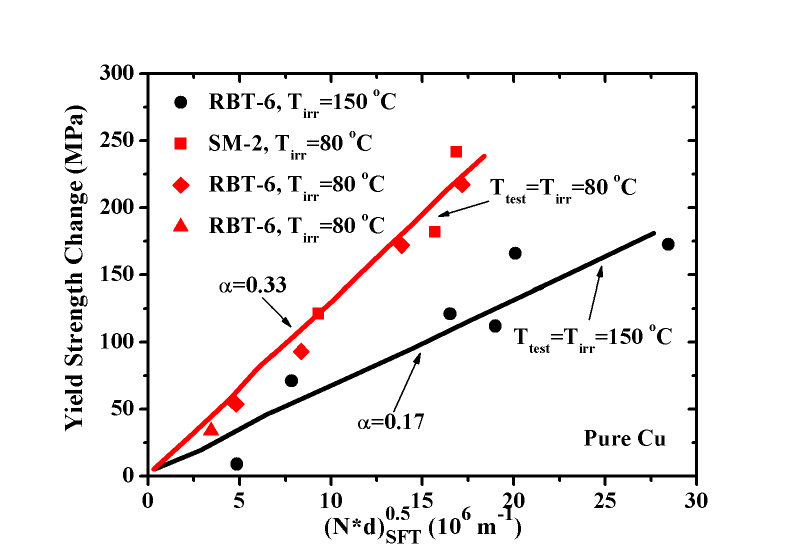
Figure 6. (color online) Temperature effect on the irradiation-hardening coefficient α of pure Cu under neutron irradiation. (Reprinted with permission from [7]. Copyright 2007 by